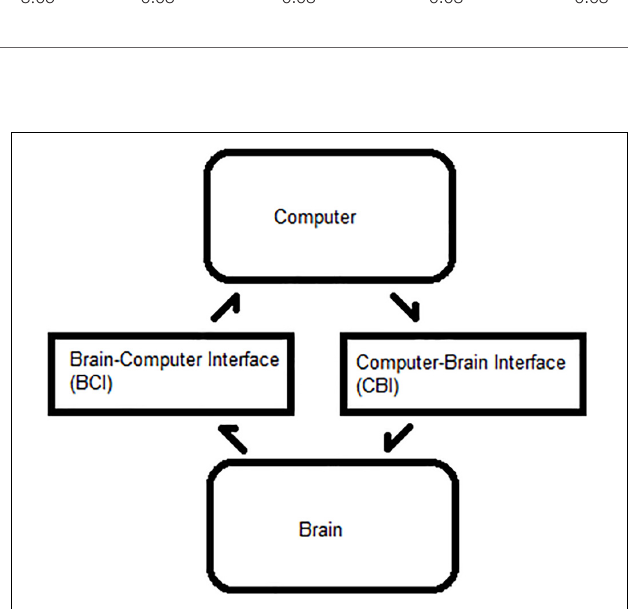
FIGURE 1 | Process flow between a brain and computer. Bidirectional flow of processes between a user’s brain and an external computer system.